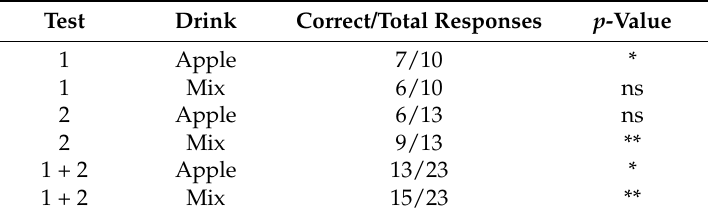
Table 6. Sensory evaluation of the apple- and mix-RCW drinks by triangle test after 150 days of